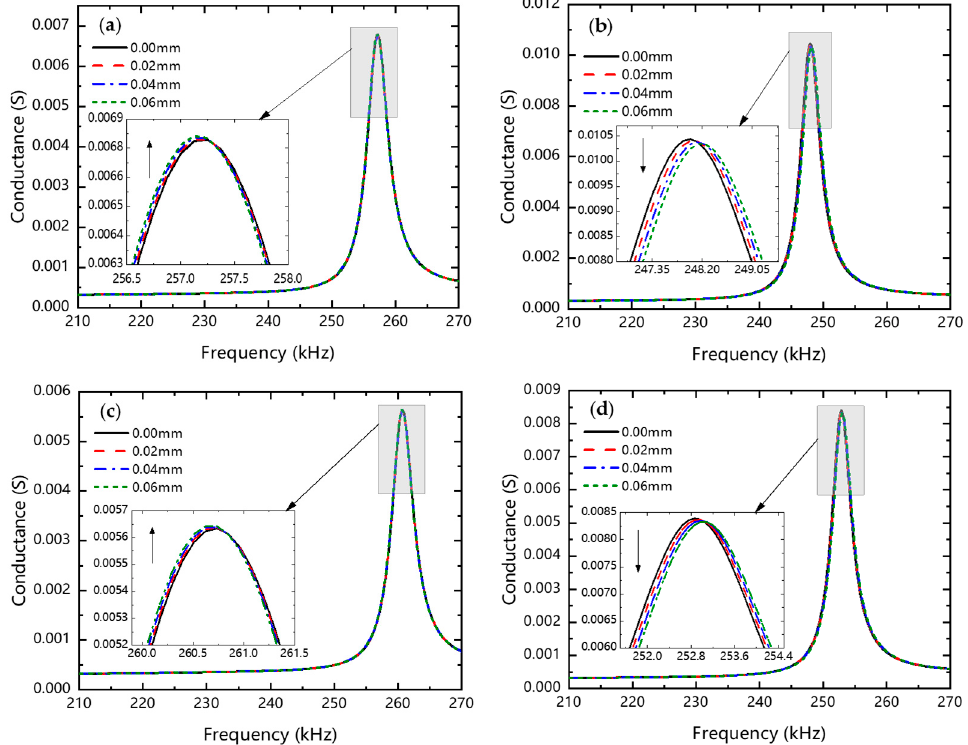
Figure 8. Numerical conductance signatures for the ( a ) 0 ◦ flat, ( b ) 90 ◦ flat, ( c ) 0 ◦ rough, and ( d ) 90 ◦ rough PZT sensors embedded in concrete cubes under elastic deformation.